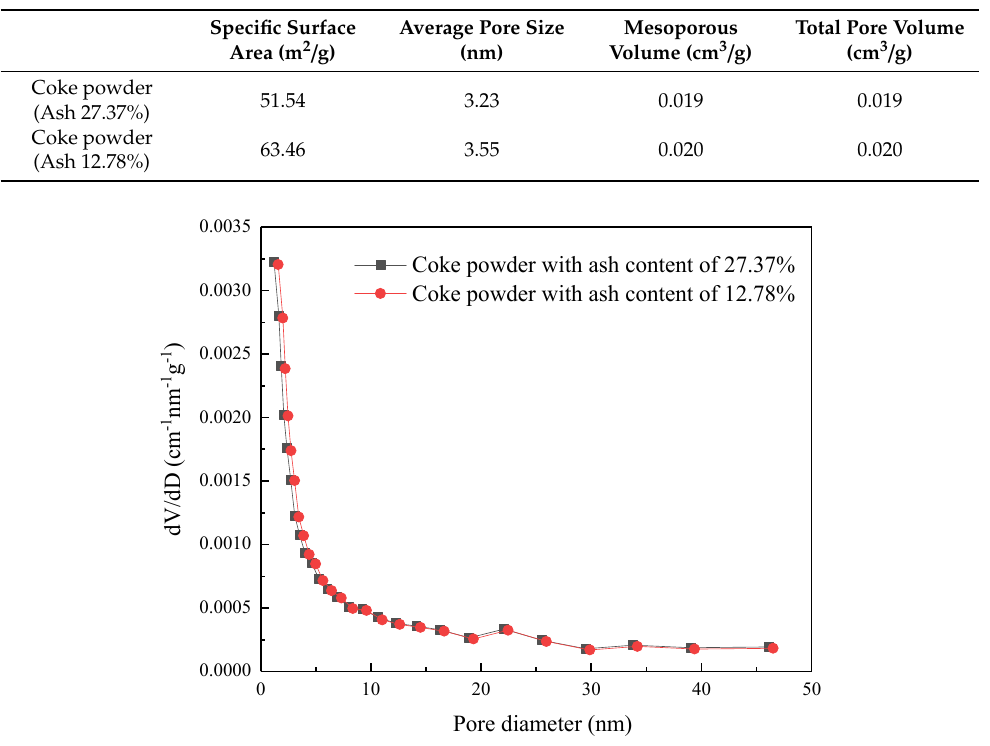
Figure 4. Pore size distribution of the coke powder used in this study examined using the automatic nitrogen adsorption instrument.